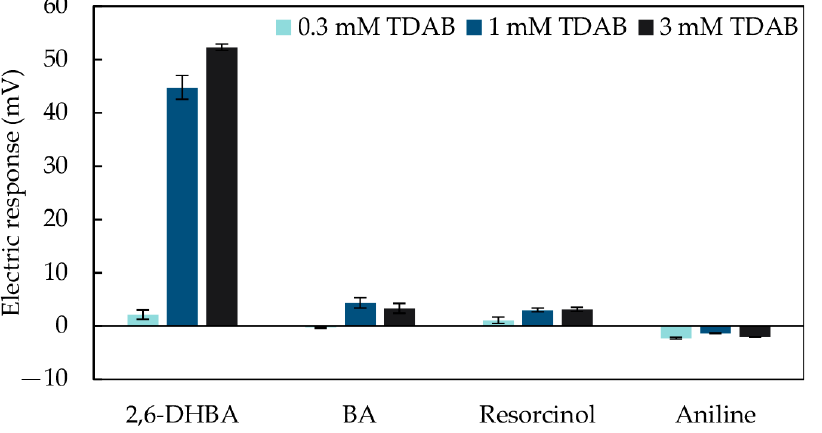
Figure 4. Response to 100 mM caffeine measured using taste sensors with lipid/polymer membrane modified with 2,6-DHBA, BA, resorcinol, and aniline. The error bar expresses the SD of the data, n = 4 (electrode) × 4 (rotation) = 16 values.